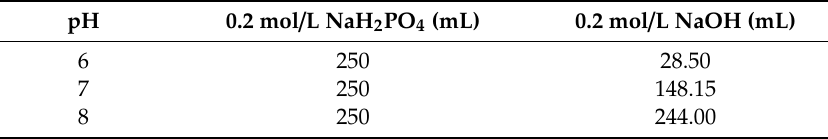
Table 1. The preparation method of NaH 2 PO 4 -NaOH bu ff